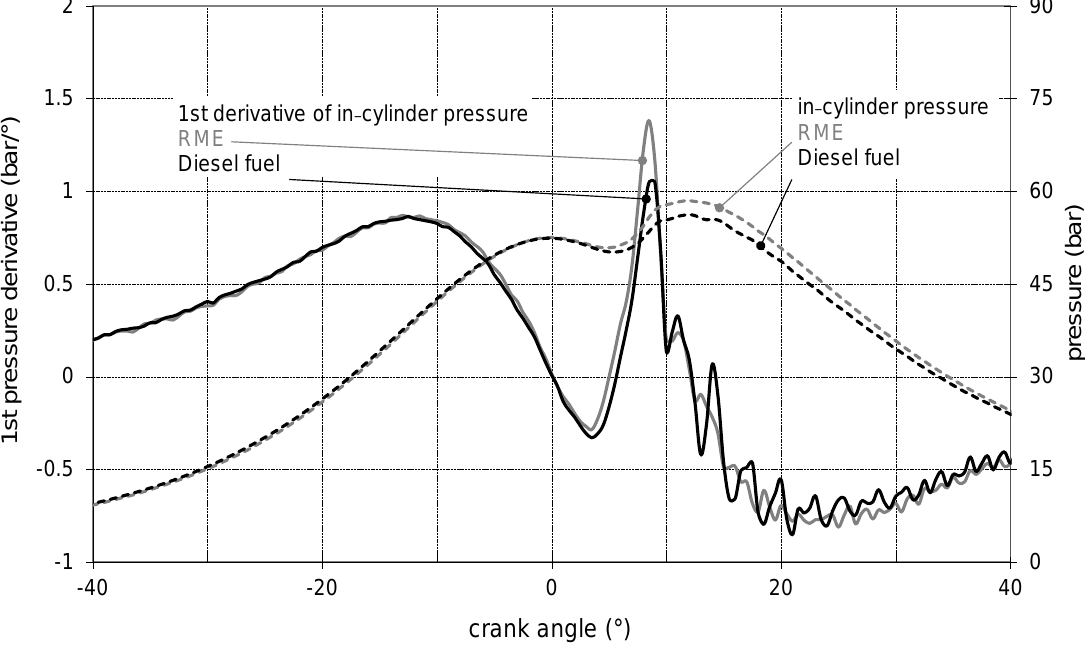
Figure 18. RME and diesel fuel in-cylinder pressures and rate of pressure rise at 2750 rpm and at full load. As the advances in the SOC were almost identical to the SOI advances, the angular ignition delays were comparable for the two fuels. This behavior can be interpreted by considering that the reduction of the chemical ignition delay due to the higher cetane number of the RME is probably compensated by an increased physical ignition delay due to a worse atomization and mixture formation. As shown in paragraph 3.2, the injection pressure of the RME and diesel fuel were similar, and the worse mixture formation is attributable to the RME’s higher surface tension, higher flash point, and poorer